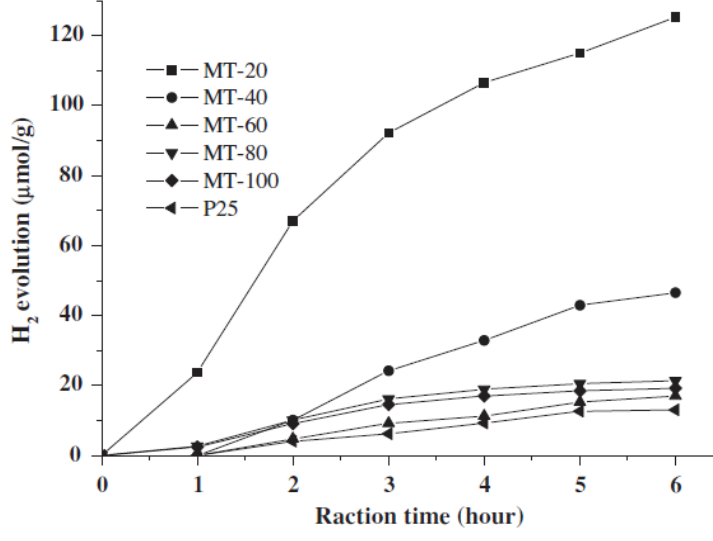
Figure 25. Depiction of solar-hydrogen production using various mesoporous TiO